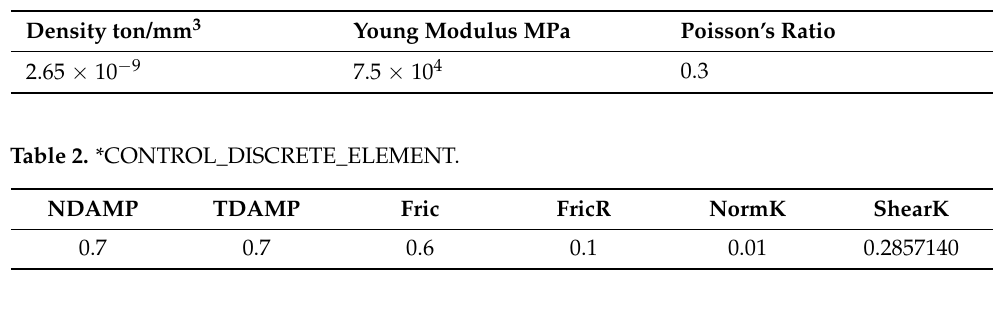
Table 3. *DEFINE_DE_TO_SURFACE_COUPLING.